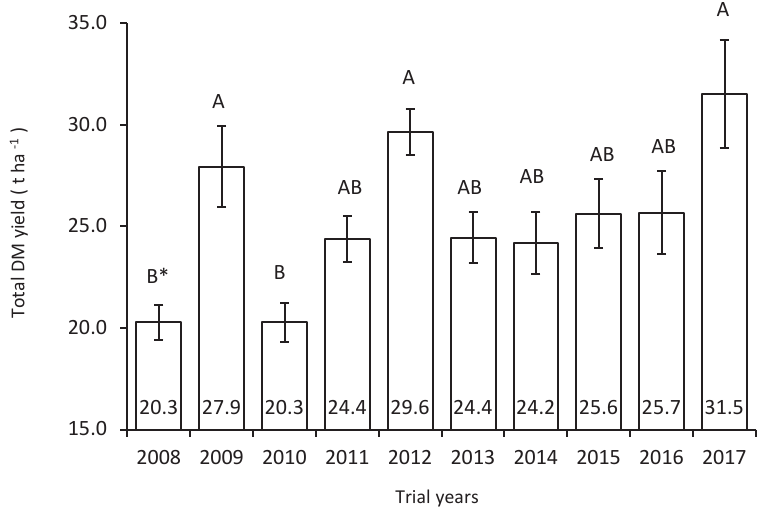
Fig. 2. Total yield of five crops (t ha –1 ) in different trial years as an average of treatments.*the means marked with the same letter do not differ statistically significantly from each